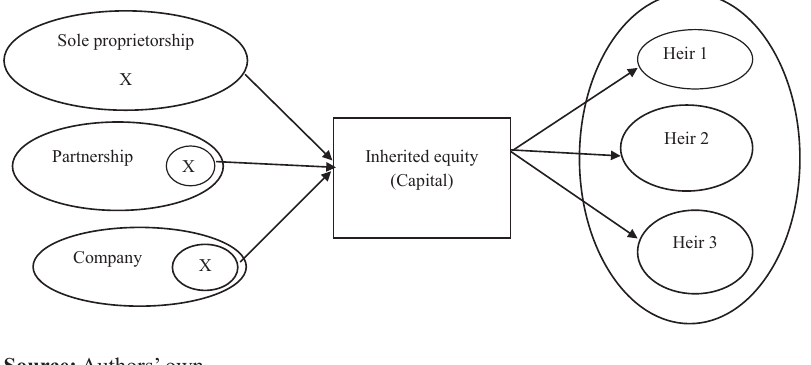
Figure 1. Transfer of